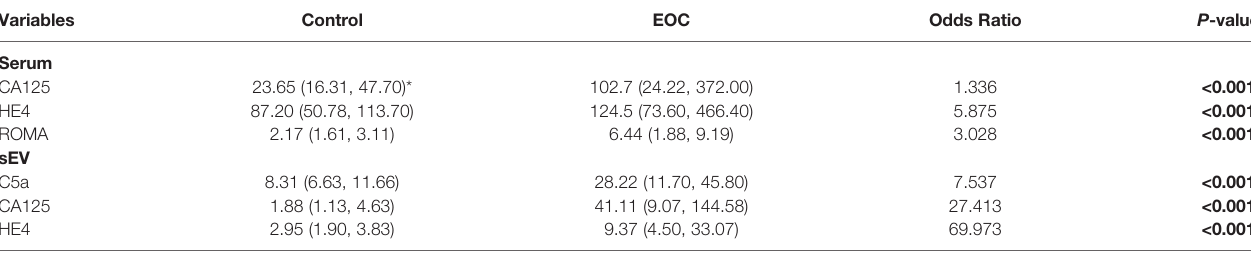
TABLE 2 | Protein levels from serum sEV and serum between the control and EOC